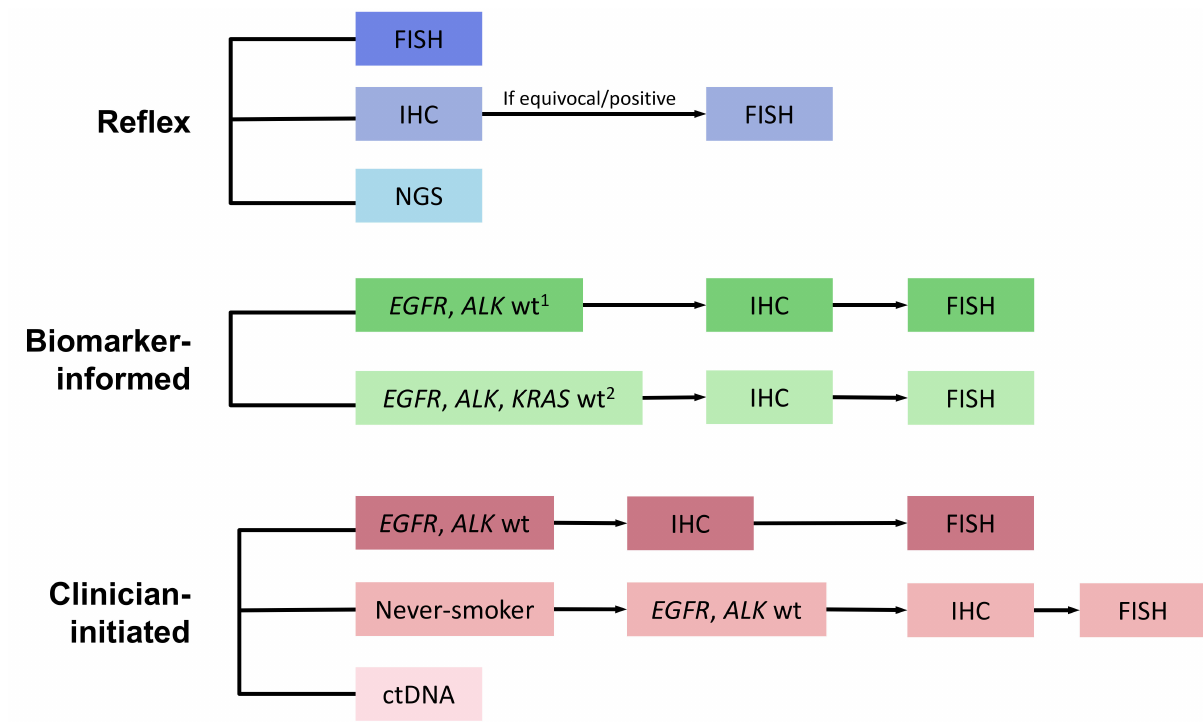
Figure 1. ROS-1 Testing Model Schema. ctDNA—circulating tumor DNA; FISH—Fluorescence in-situ hybridization; IHC—Immunohistochemistry; NGS—Next-generation sequencing; wt—wildtype. Footnotes: 1 If EGFR , ALK , or KRAS positive, then no further testing performed; wt—wildtype; 2 PCR-based